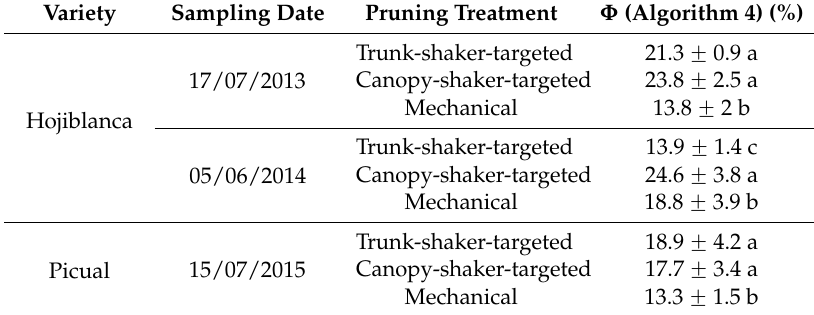
Table 3. Crown porosity measured in different olive varieties and dates for each pruning treatment. Values are mean ˘ standard deviation. Different letters showed significant differences ( ρ < 0.05) according to Duncan’s test between different pruning treatments and in the same sampling